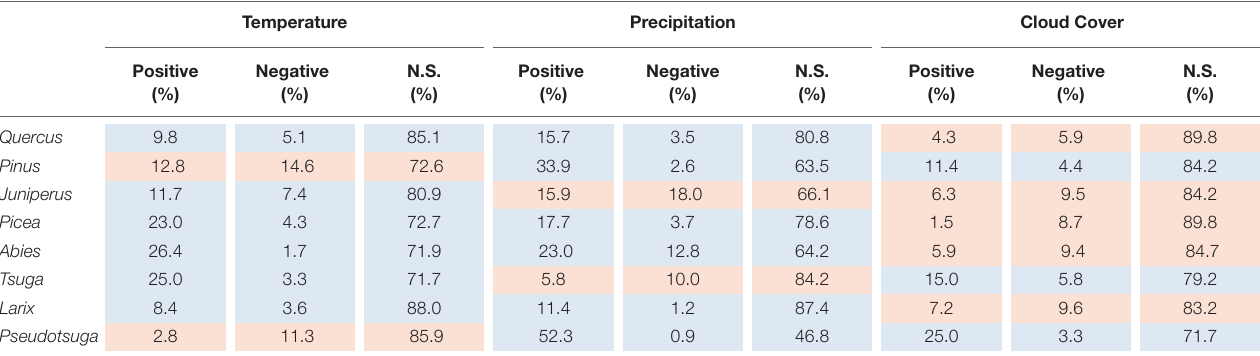
Mexico 4.2 Blue (red) shading indicates regions where more sites showed positive (negative) responses.